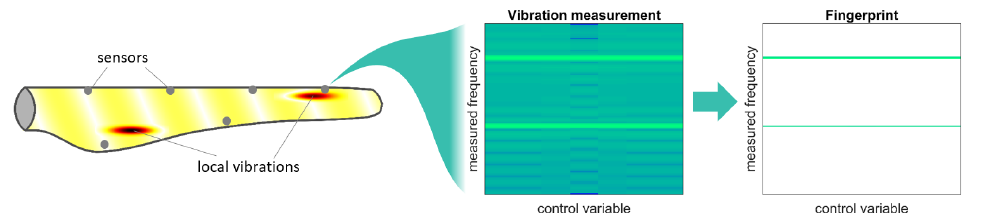
Figure 1. Proposed approach: The local vibration characteristic of the blade is measured by dis- tributed sensors on the blade ( left ). Vibration measurements ( middle ) are used to extract characteris- tic fingerprints with reference to a reference variable, e.g., rotation speed ( right